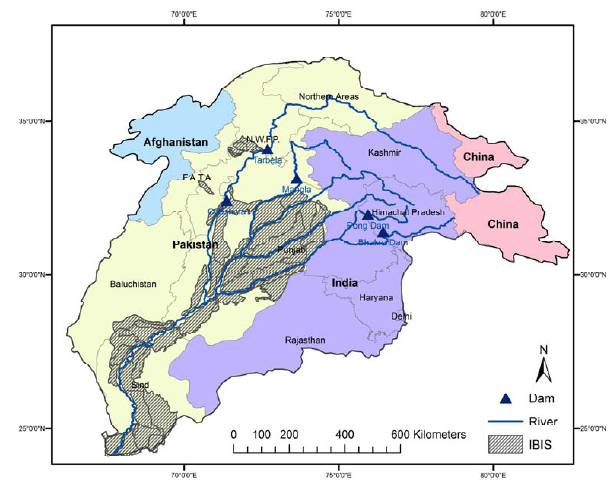
Fig. 1. The Indus Figure 1. The Indus basin 3